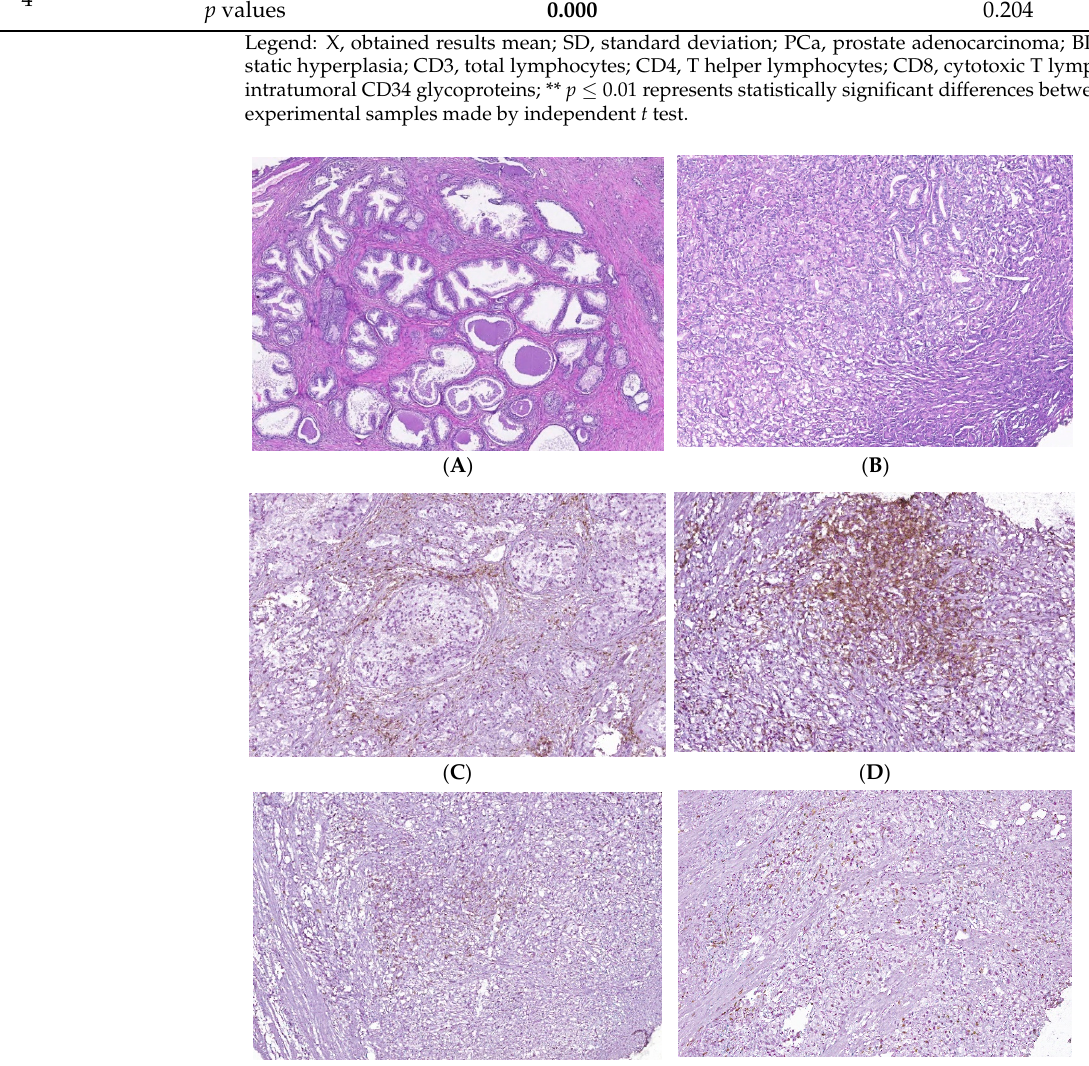
Table 5. Evaluation of T lymphocyte biomarkers and intratumoral expression of CD34 in prostate adenocarcinoma, benign prostatic hyperplasia, and non-malignant adjacent tissue samples .